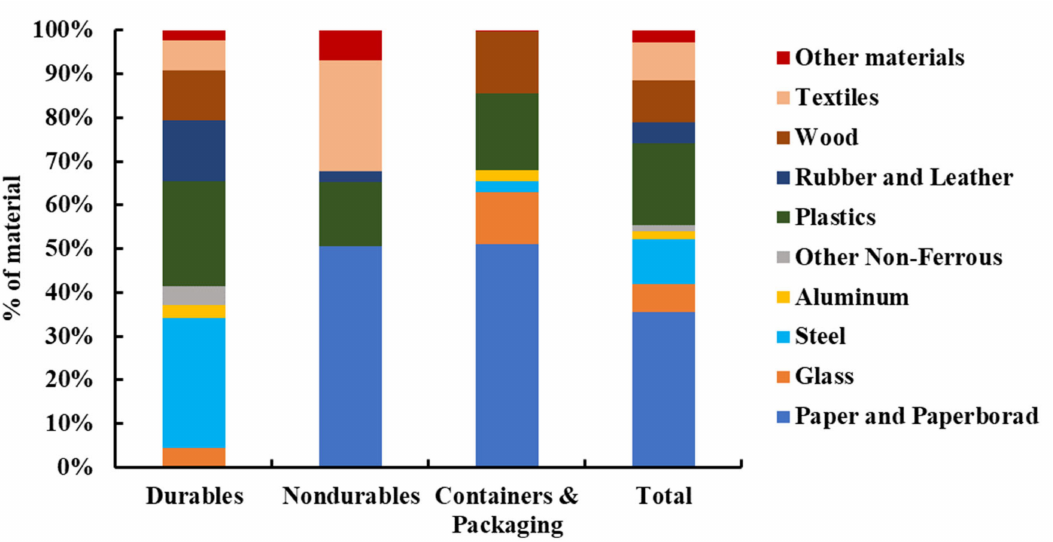
Figure 2. Composition of waste products in the U.S. in 2018. Other non-ferrous include mainly lead from lead-acid